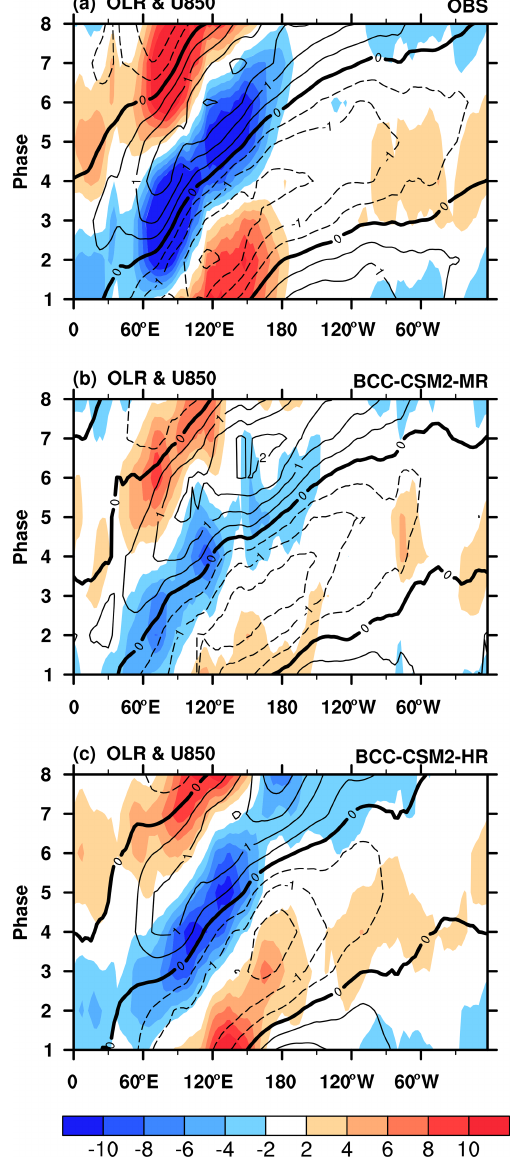
Figure 17. Hovmøller diagrams of MJO phase-composited OLR (shaded) and 850hPa zonal wind anomalies (contour lines) aver- aged between 10 ◦ S and 10 ◦ N from (a) ERA5 wind and NOAA OLR reanalyses, (b) BCC-CSM2-MR, and (c) BCC-CSM2-HR simulations for the period from 1995 to 2014. The MJO phase is defined by the two principal components corresponding to leading multivariate EOFs of OLR, 850 and 200hPa zonal wind anomalies as in Wheeler and Hendon